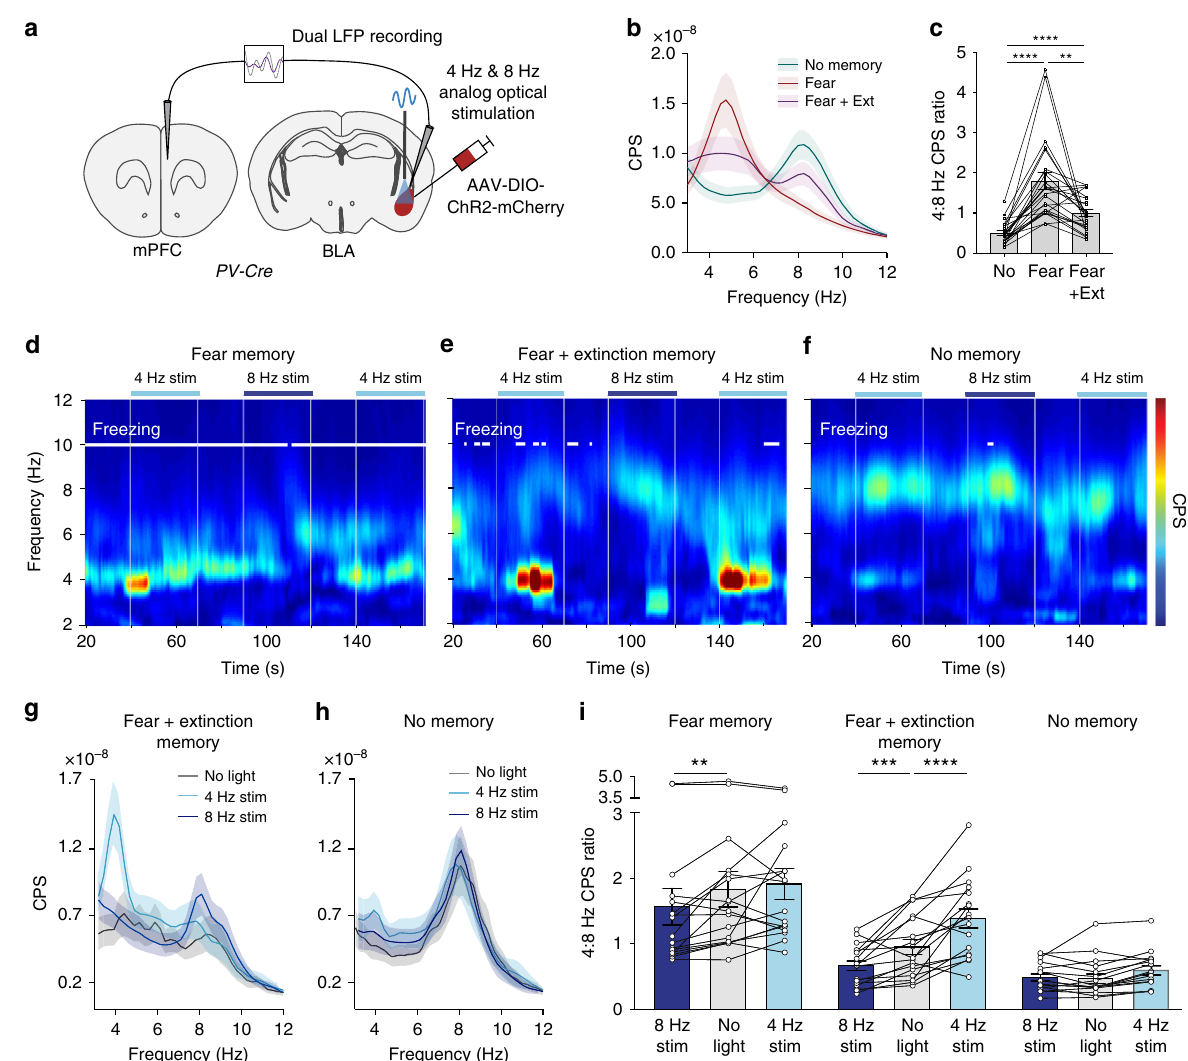
Fig. 5 Memory-speci fi c effects of 4 Hz and 8 Hz BLA stimulation on BLA-mPFC oscillatory activity. a Schematic of strategy for in vivo control of BLA PV- interneurons with simultaneous dual LFP recording. b , c Fear conditioning increases, while extinction learning reduces 4:8 Hz cross-power spectrum. Averaged cross-power spectra ( b ; n = 24 mice) and quanti fi cation as 4:8 Hz CPS ratio ( c ; one-way repeated measures ANOVA: F (1.201, 27.62) = 27.5, P < 0.0001, n = 24 mice. Tukey ’ s multiple comparison ’ s test: No memory vs. Fear memory: P < 0.0001; No memory vs. fear + ext memory: P < 0.0001; fear vs. fear + ext memory: P = 0.0047). d – f Representative cross-power spectrograms demonstrating bidirectional control of freezing and BLA-mPFC cross-power spectrum by 4 Hz and 8 Hz optical stimulation, exclusively during post-extinction retrieval (Fear + Extinction Memory). g , h Average BLA-mPFC cross- power spectra illustrating frequency-speci fi c effects of 4 Hz and 8 Hz optical stimulation during the post-extinction retrieval trial ( n = 16 mice). A stimulation-induced 4 Hz peak emerges only in the Fear + Extinction memory condition, and not in the No-memory condition. i Optical stimulation of BLA PV-interneurons has a bidirectional effect on BLA-mPFC cross-power spectrum in the conditioned context following, but not before, extinction learning (two-way repeated measures ANOVA: trial F (2,30) = 15.91, P < 0.0001, stimulation F (2,30) = 18.58, P < 0.0001, trial × stimulation F (4, 60) = 7.96, P < 0.0001, n = 16 mice; Holm-Sidak ’ s multiple comparisons test; fear memory: no light vs. 8 Hz stim t (60) = 3.29, P = 0.0034; no light vs 4 Hz stim t (60) = 0.60, P = 0.55; fear + ext memory: no light vs 8 Hz stim t (60) = 3.43, P = 0.0011; no light vs 4 Hz stim t (60) = 5.16, P < 0.0001; no memory: no light vs 8 Hz stim t (60) = 0.18, P = 0.86; no light vs 4 Hz stim t (60) = 1.43, P = 0.29). All error bars and shaded area: mean ±